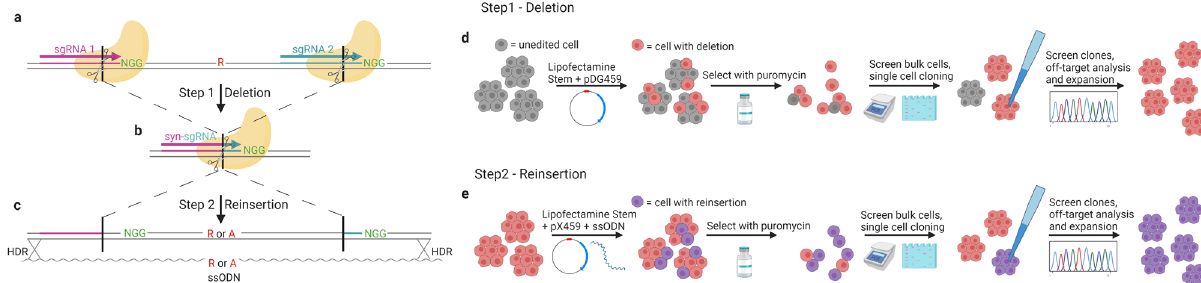
Figure 1. CRISPR Del/Rei overview and workflow. ( a ) In Step 1, two sgRNAs (pink and blue) mediate a deletion containing the target base (red, “R” for reference allele) and portions of the protospacers (pink and blue). Importantly, one PAM site (green) is left external to the deletion. ( b ) Once the deletion is made, the protospacers are destroyed which prevents further Cas9 recruitment and cleavage, resulting in high editing efficiency. In Step 2, the sequence spanning the deletion junction (black vertical line) is used as a protospacer for a synthetic sgRNA (syn-sgRNA, pink and blue). The syn-sgRNA coupled with the spared PAM site mediates reinsertion of the deleted sequence, including any desired allele of the target base (“A” for alternate allele). ( c ) Once the sequence is reinserted by HDR, the syn-sgRNA protospacer is destroyed, again preventing additional Cas9 cleavage and yielding high editing efficiency. ( d ) Deletion workflow with transfection of pDG459. ( e ) Reinsertion workflow with transfection of pX459 and